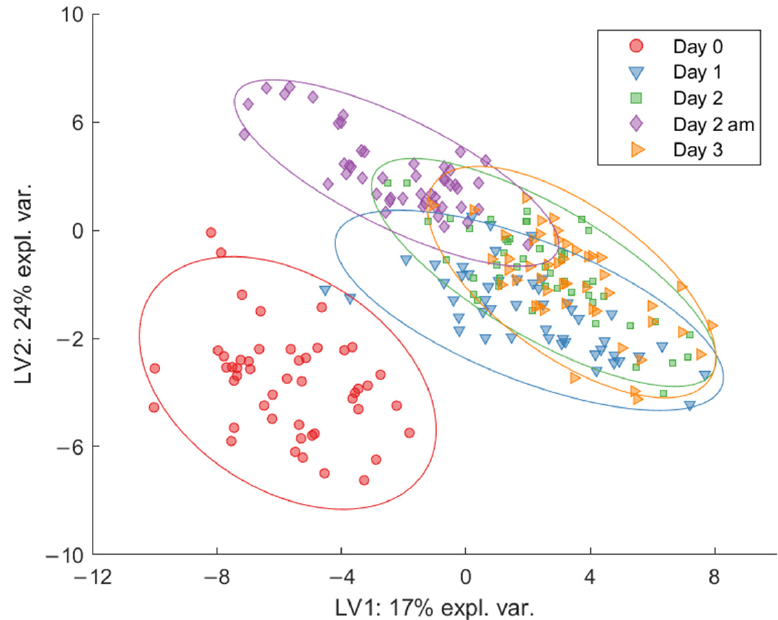
Figure 2. Multilevel partial least squares discriminant analysis (M-PLS-DA) model for the effect of walking on the breath volatile organic compound (VOC) profile for St0. The model includes all sample time points. A clear separation between Day 0 and the remaining time points (Day 1–Day 3) is revealed, indicating a significant change in the breath profile at the onset of exercise compared against Day 0.